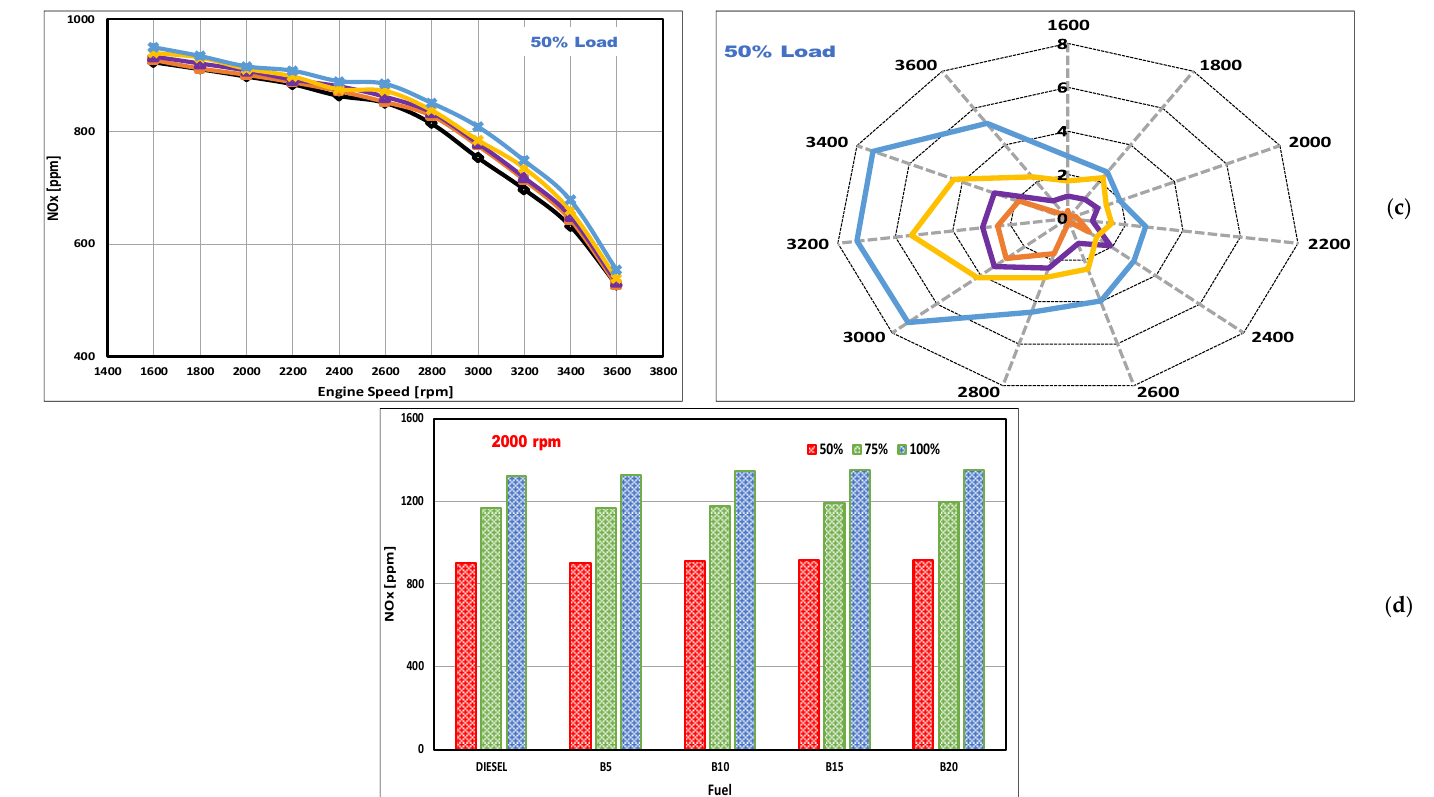
Figure 6. NOx variations with engine speed and load, presented as trends (left) and the normalized value contours (right) for ( a ) 100%, ( b ) 75%, and ( c ) 50% loading. ( d ) Comparison of the results for all fuels at all loads at 2000 rpm.